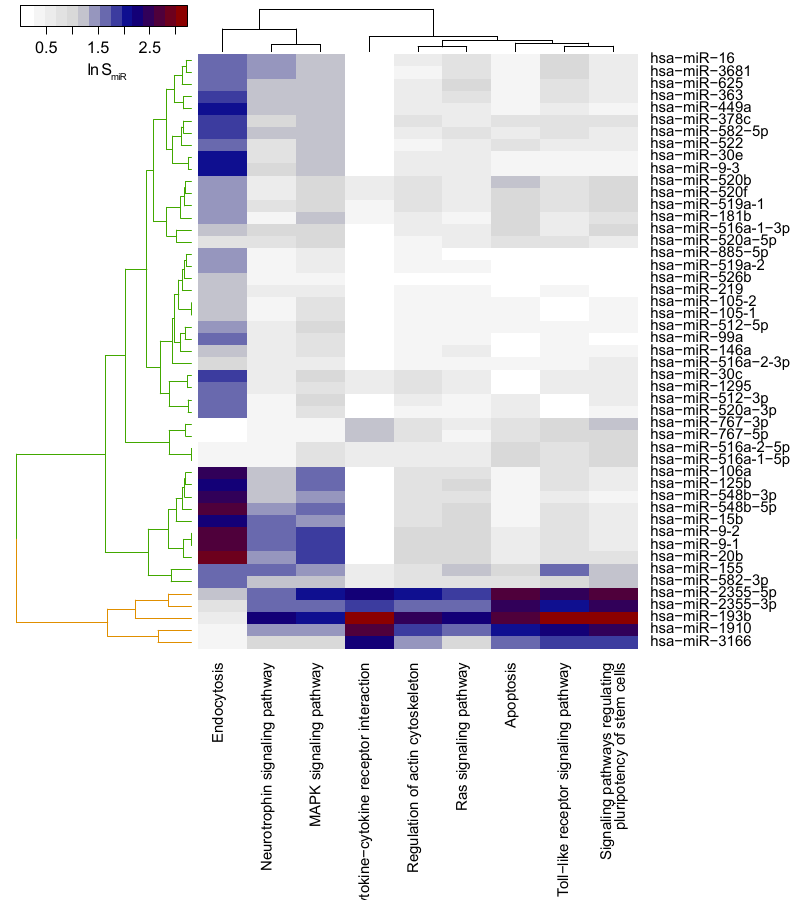
Figure 6. Functional characterization of the HNSCC mi-/mRNA network. Heatmap of miR scores S miR ( v ) for each miRNA v in the network indicating the functional role in the significantly locally enriched KEGG